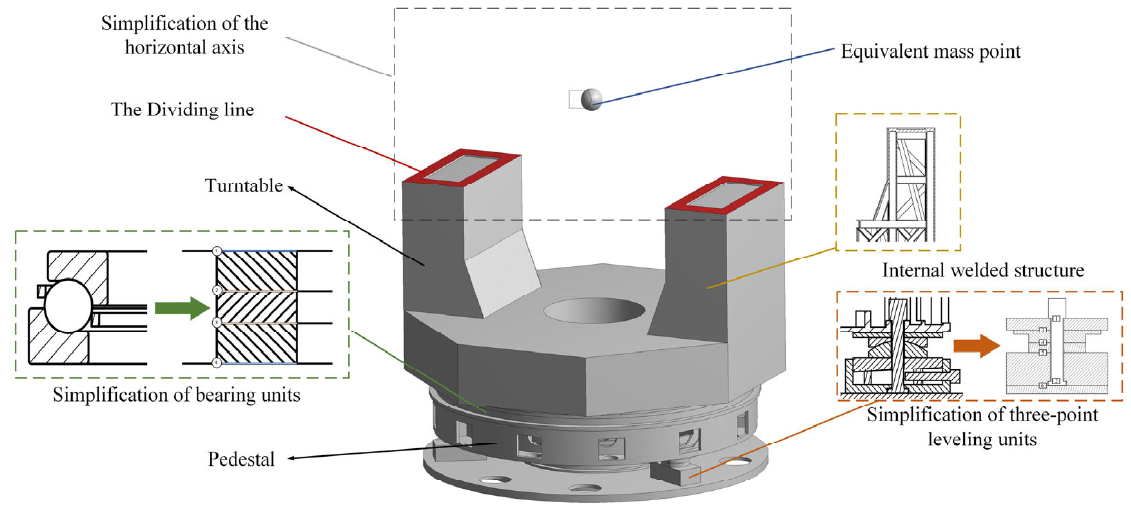
Figure 7. Schematic diagram of the simplified process of tracking frame model.